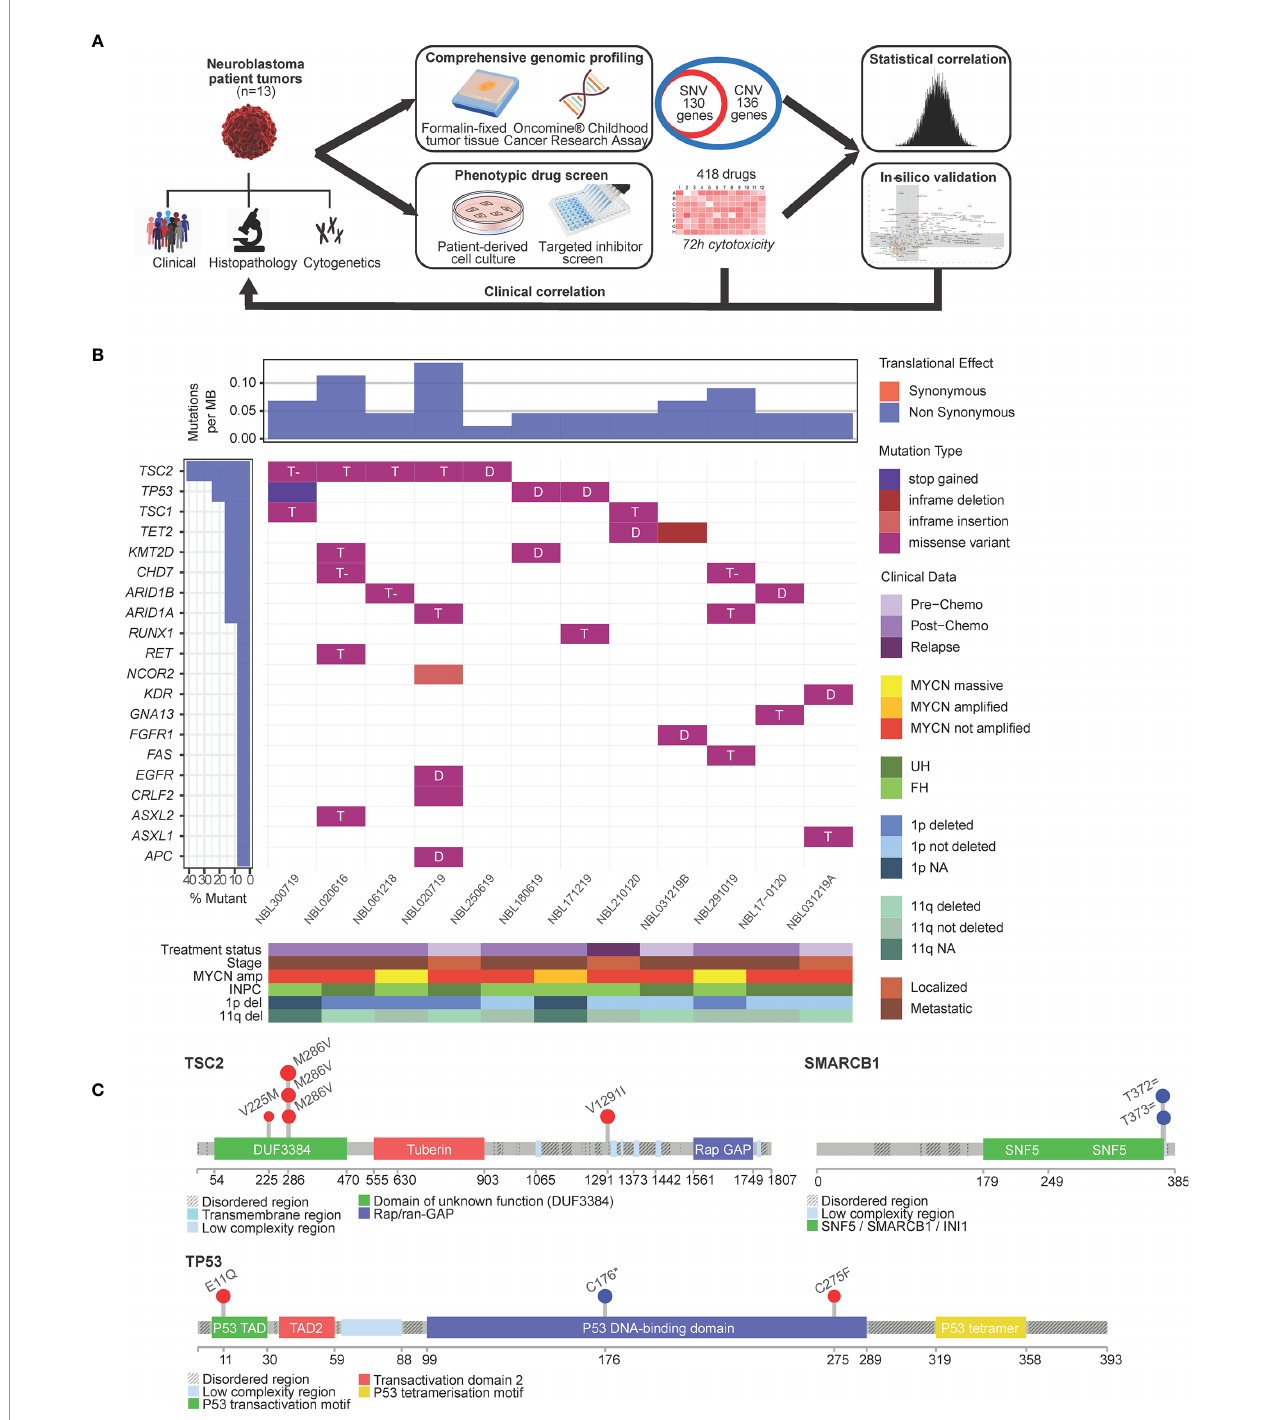
FIGURE 1 | Single nucleotide variants in neuroblastoma are largely not actionable. (A) Schema of experimental protocol. (B) Waterfall plot of the distribution of mutations found in 13 neuroblastoma tumors, fi ltered for population SNPs, re fl ecting mutation type predicted according to Sift in each identi fi ed variant (main plot), frequency of mutations per sample (upper panel), frequency of samples mutated (left panel) and clinical-pathological covariates (lower panel heatmap). T, tolerated; T- tolerated (low); D, deleterious; INPC, International Neuroblastoma Pathology Classi fi cation; UH, unfavorable histology; FH, favorable histology. (C) Lollipop plots showing overall low frequency of mutations but occuring in expected hospots: TSC2 mutations in the DUF3384/TSC1-binding domain and TP53 variants in the P53 DNA-binding hotspot region; germline splice variants in SMARCB1 occurred in the coiled-coil C-terminal domain of the BAF47 subunit associated with mutations of SWI/SNF